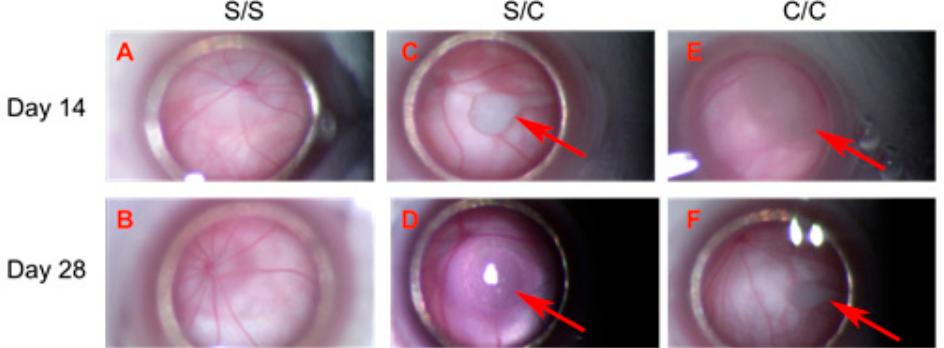
Figure 1. Transplanted gmRPCs visualized in vivo via fundus photography through surgical mi- croscope (all = left eye, OS). ( A ) and ( B ), sham-treated animals (sham/sham, S/S); ( C ) and ( D ), con- trol animals with sham-treated right eye followed by gmRPCs-treated left eye (sham/cell, S/C), and animals with both eyes treated sequentially with gmRPCs (cell/cell, C/C) were observed and imaged through the surgical microscope. Upper panel ( A , C , E ) shows images of OS taken on Day 14 post second injection; lower panel ( B , D , F ) shows images of OS taken on Day 28 post second injection. Allografts were seen as pale colored cell clumps (arrows) visible in the vitreous of cell-injected left eyes (S/C, C/C) at both time points (Day 14: ( C , D ); and Day 28: ( E , F )). Apart from grafts, there was no obvious inflammation or additional abnormality seen in the anterior and posterior segments, as viewed axially in this manner.